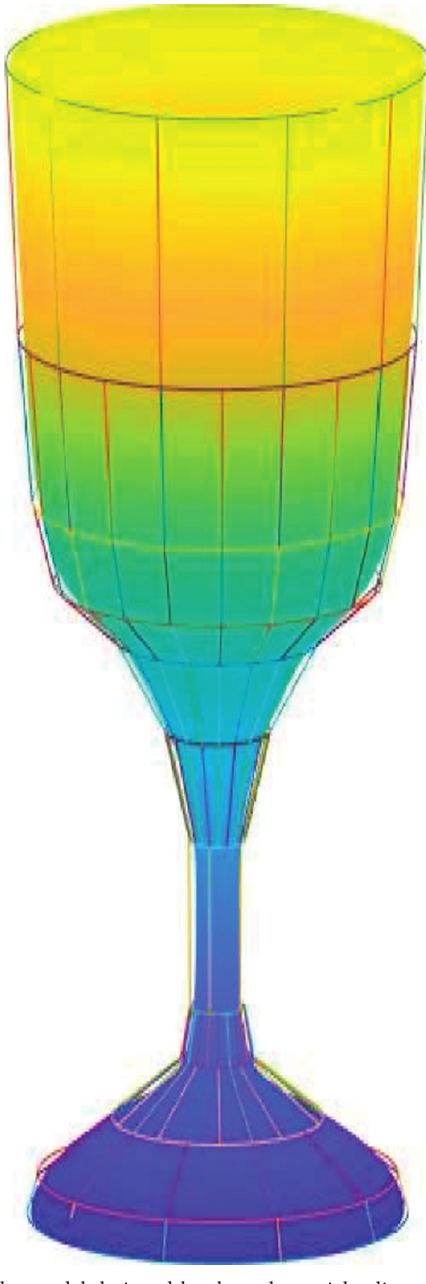
Figure 7: A goblet model designed by the polynomial splines with control